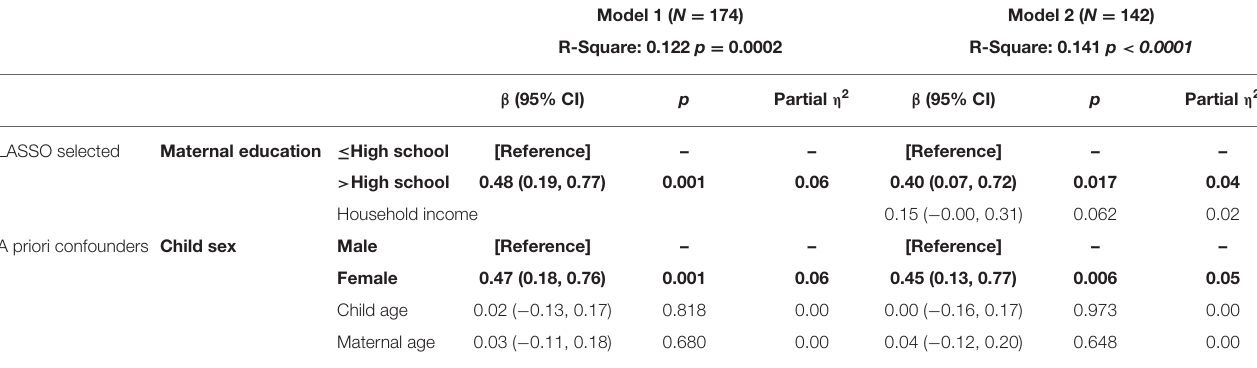
TABLE 4 | Results from adjusted model of LASSO-selected predictors for IQ with standardized